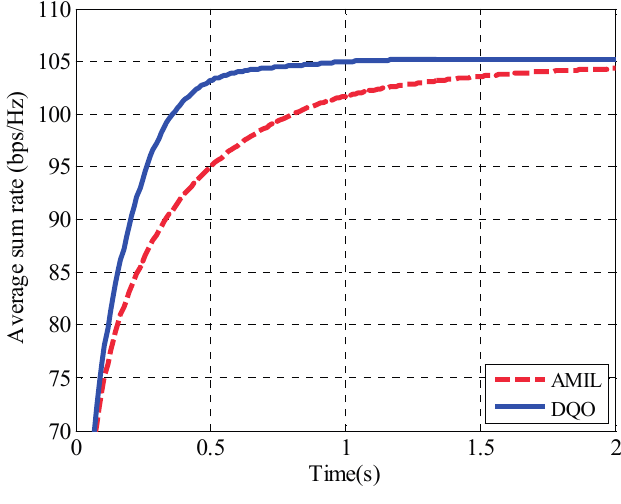
Figure 8. Convergence curves of the average sum rate in (5 × 5, 2) 4